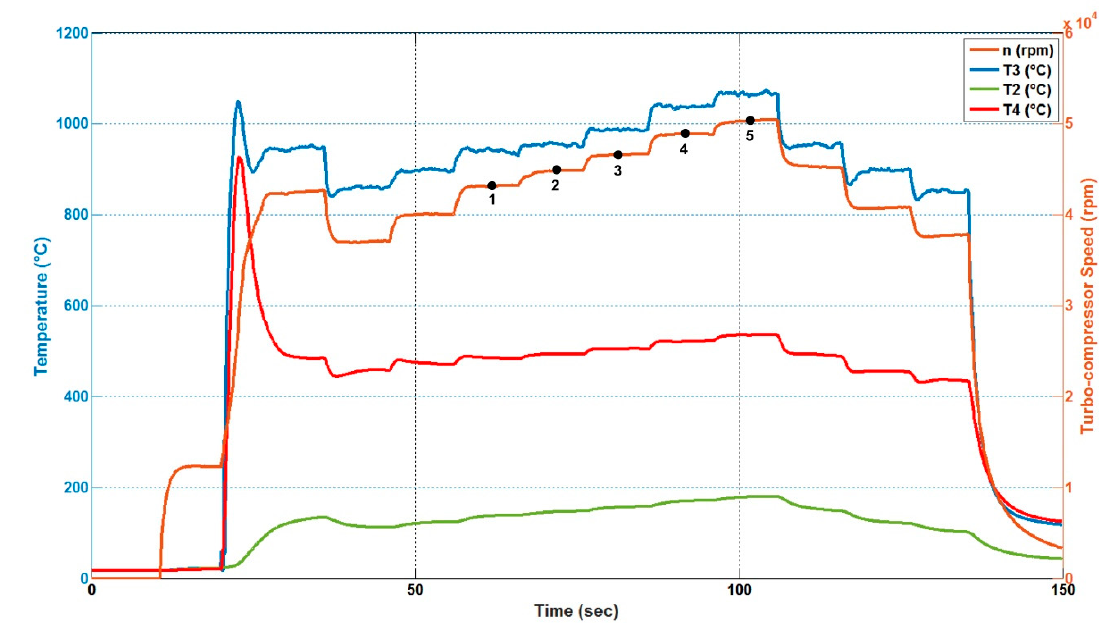
Figure 14. The measured parameters during a single run of the iSTC-21v engine. Appl. Sci. 2019 , 9 , x FOR PEER REVIEW